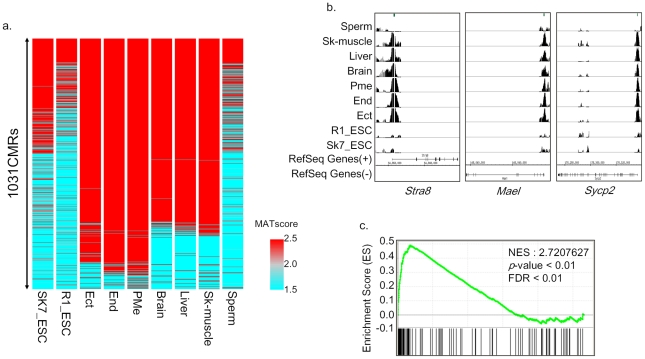
Testis specific genes are commonly methylated in somatic lineages.a) Overview of DNA methylation profiling b) Methylation of germline-specific genes in somatic lineages. A green line indicates a CpG island region. c) Gene Set Enrichment Analysis (GSEA) determines whether a defined set of genes shows concordant changes between two biological states. The normalized enrichment score (NES) reflects the degree to which a gene set is upregulated (positive NES). Corresponding p values are indicated.